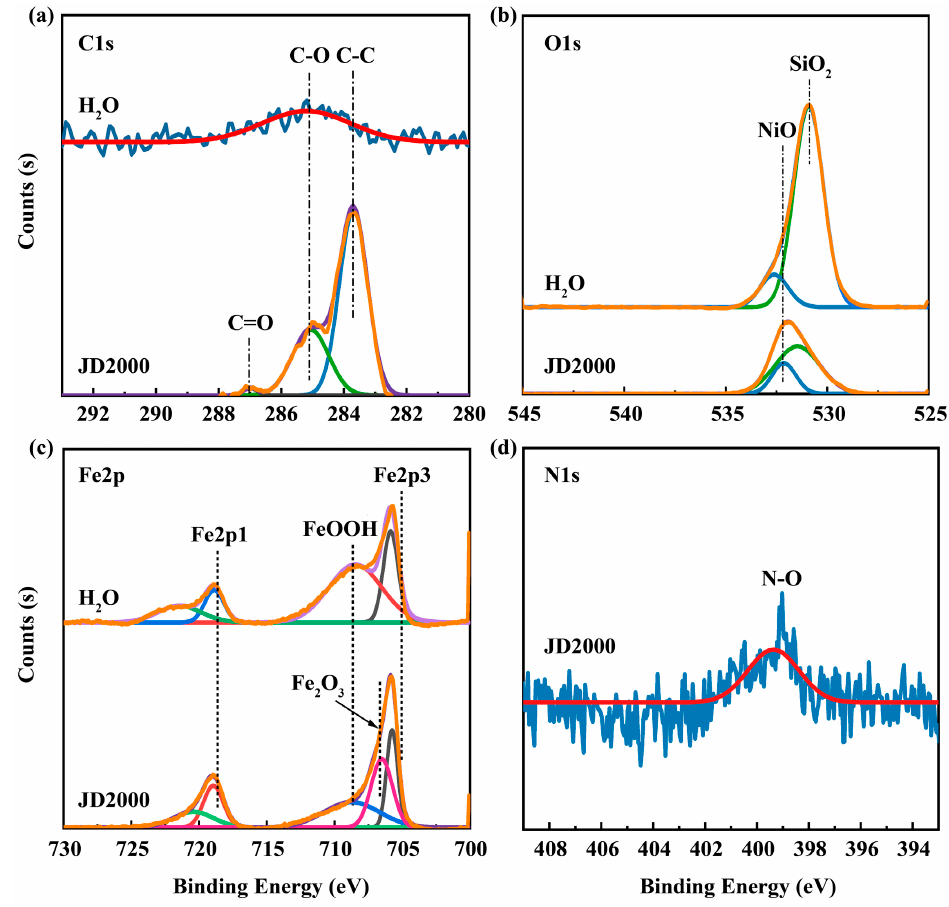
Figure 15. The XPS spectra of ( a ) C1s, ( b ) O1s, ( c ) Fe2p and ( d ) N1s on the wear scar of the steel ball lubricated using the 2 wt.% JD2000 aqueous solution as measured using the UMT tribometer.